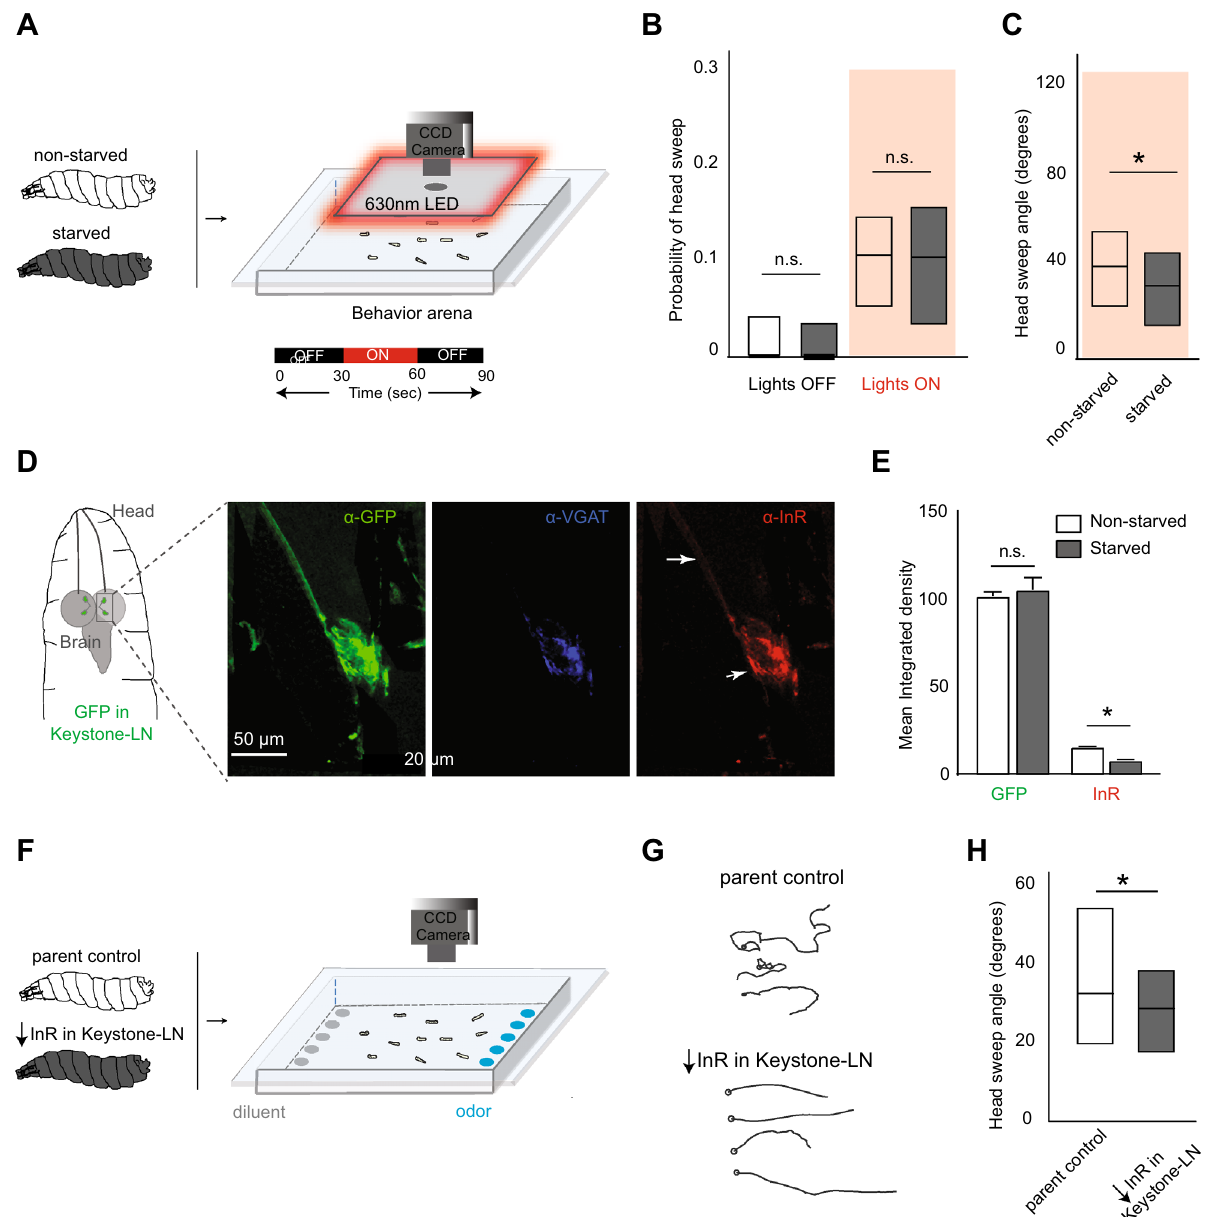
Figure 5. Satiety state and insulin signaling affect head-sweep behavior. ( A ) Starved and non-starved transgenic larvae expressing CsChrimson in Keystone-LN are subjected to the optogenetics assay. Larval movements are recorded. ( B ) The probability of head sweeps for non-starved (white) and starved larvae (grey) under lights OFF (left) and lights ON (right) are plotted on the y-axis. Robust non-parametric ANOVA (R-fit package), n = 76 for Lights OFF, n = 15 for Lights ON. ( C ) Magnitudes of head sweep for fed (green) and starved larvae (blue) are plotted on the y-axis. Robust non-parametric ANOVA (R-fit package), *p = 0.0172, n = 72 for fed samples, n = 49 for starved samples. ( D ) Figure depicting the front end of a third-instar Drosophila larva. Keystone-LN is highlighted in green. The rectangular inset marks the region of interest during confocal imaging. α-GFP antibody pinpoints Keystone-LN. α-VGAT antibody labels vesicular GABA transporter. α-InR antibody labels insulin receptors. ( E ) GFP and InR protein levels were quantified in Keystone-LNs (mean ± SEM). Student’s t test (two-tailed), p < 0.05. ( F ) Transgenic larvae expressing UAS-InR-RNAi in Keystone-LN and parent controls are subjected to an odor gradient (4-Hexen-3-one, 10 –2 vol:vol). Larval movements are recorded. ( G ) Example tracks of control larvae and larvae expressing low InR in Keystone-LNs. ( H ) Magnitudes of head sweep (median, IQR) for control larvae (white, n = 176) and larvae expressing low InR in Keystone-LNs (grey, n = 92) are plotted on the y-axis. Robust non-parametric ANOVA (R-fit package), *p =